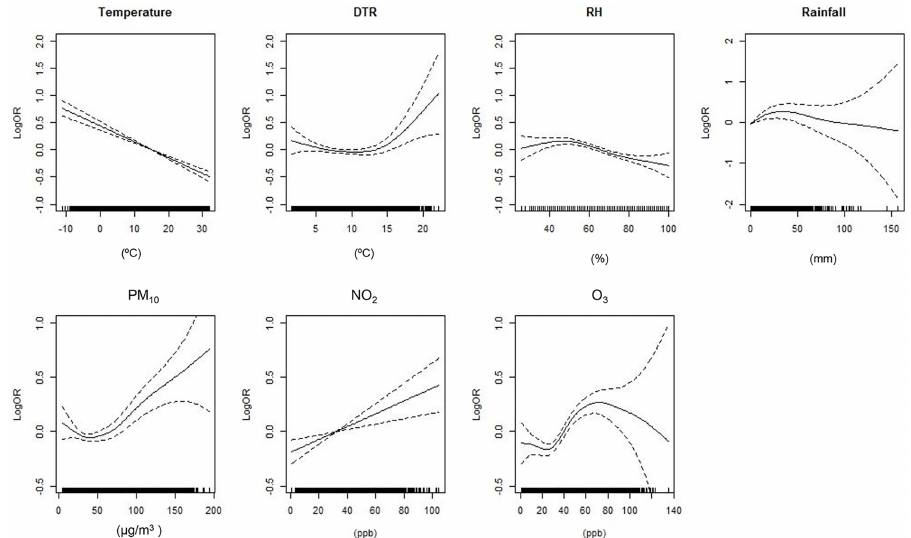
Fig 1. Relationship of meteorological variables and air pollution with Atopic Dermatitis(AD) symptoms. Each figure shows the spline curve (solid lines) with a 95% confidenceintervals(two dashed lines). All variablesare based on the same model on the same day, without using moving averages for the exposureto each risk factor. The model was controlled for the severity score at the initial visit, age, sex, presenceof fever, and day of week (DOW). RH: relative humidity;DTR, diurnaltemperature range; OR: odds ratio.